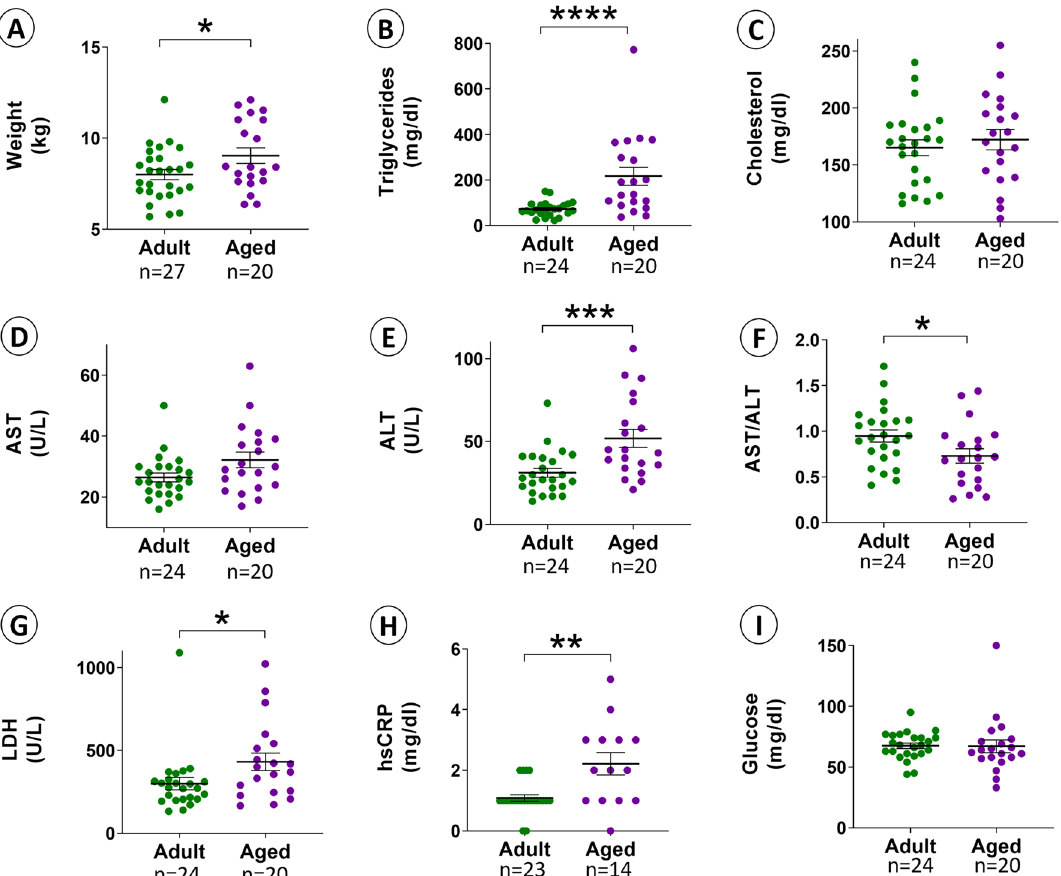
Figure 2. Weight and metabolic panel studies in adult and aged rhesus macaques. Body weight was significantly higher in the aged compared to adult rhesus macaques ( p < 0.05) ( A ). There was a statistical elevation of triglycerides ( p < 0.0001), ALT ( p < 0.001), LDH ( p < 0.05), and hsCRP ( p < 0.01) in the aged cohort compared to adult animals ( B , E , G , H ), whereas the AST/ALT ratio was reduced in aged animals compared to the adults ( p < 0.05) ( F ). There was no detectable difference between the groups for cholesterol, AST, and glucose levels ( C , D , I ). Data are presented as mean ± SE, and statistics are shown as * indicating p < 0.05, ** indicating p < 0.01, *** indicating p < 0.001, and **** indicating p < 0.0001 between (n = 12, p < 0.01) and 52.3 ± 8.3 ml for adults (n = 27, p < 0.001) (Fig. 3G). PVR 97.6 ± 10.3 ml, 67.6 ± 7.8 ml, and 194.8 ± 72.2 ml for the adult (n = 27), aged remain (n = 11), and aged outlier (n = 8) cohorts, respectively, and not statistically different (Fig. 3H). Capacity-IV25 was statistically larger at 332.5 ± 55.1 ml in aged outliers (n = 8) compared to the corresponding Capacity-IV25 for remaining aged subjects at 144.9 ± 18.7 ml (n = 12, p < 0.0001) and adults at 149.9 ± 10.6 ml (n = 27, p < 0.0001) (Fig. 3I). Principal component analysis. Principal component analysis (PCA) was performed to identify possible clusters and outliers among the adult and aged rhesus macaques. Thirteen variables associated with DU or meta- bolic syndrome were selected for each subject and included age, weight, IV25, Bcomp, Capacity-IV25, glucose, ALT, AST, AST/ALT ratio, LDH, cholesterol, triglycerides, and hsCRP. The PC analysis allowed for each animal to be represented by a single data point in a 2-dimensional space, expressed as the first and second principal components (PC1 and PC2). The mean PC1 score for the aged outlier group was 3.11 ± 0.80 (n = 8) and significantly higher than the cor- responding PC1 score of 0.54 ± 0.42 (n = 12) for the aged remain group ( p < 0.01) and − 1.16 ± 0.16 (n = 27) for adults (0.0001) (Fig. 4A). The mean PC1 score was also significantly higher for the aged remain group compared to adults ( p < 0.0001) (Fig. 4A). The mean PC2 score for the Aged outlier group was 0.91 ± 0.58 (n = 8) and signifi- cantly higher than the corresponding PC2 score of − 0.27 + 0.22 (n = 27) for adults ( p < 0.05) but not statistically different from the mean PC2 score of 0.01 + 0.61 (n = 12) in the Aged remain group (Fig. 4B). The mean PC2 score was not statistically different between the Aged remain and Adult groups (Fig. 4B). Cartesian representation of principal component (PC) 1 and 2 for each subject allowed for a display of the data set in two dimensions (2D) (Fig. 4C). Each subject was assigned into one of three groups. The adult subjects formed one group, and the aged subjects were divided into two separate groups based on urodynamic features. Specifically, aged subjects with a Bcomp beyond the largest Bcomp for adults were separated out as aged outliers,